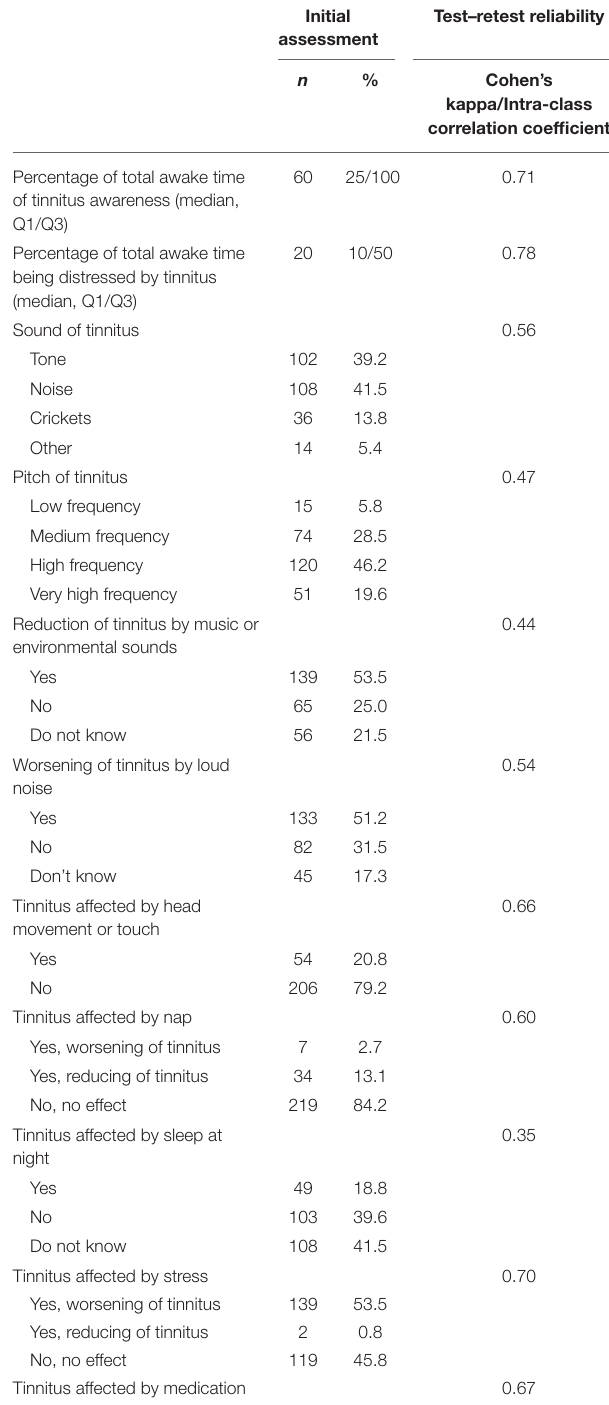
TABLE 2 | Tinnitus-related data and test–retest reliability assessed with the Tinnitus Sample Case History Questionnaire